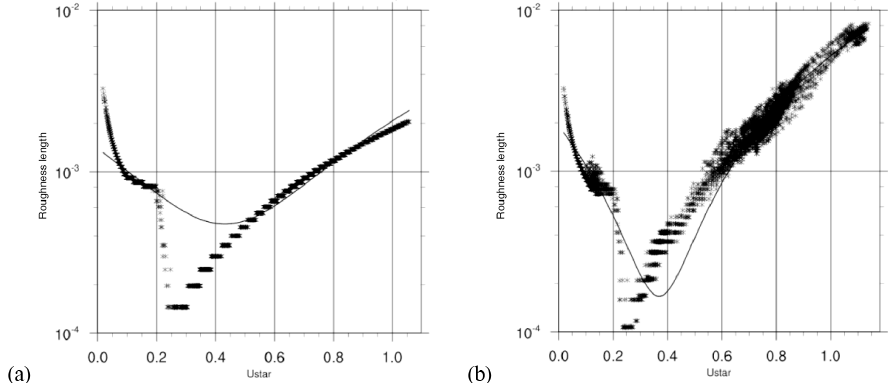
Figure 15. Roughness length (m) dependence to the friction velocity (ms − 1 ) for (a) the CTRL and (b) WEW experiments. The diagrams consist of selected sea points with severe winds during the period 4–11 January 2012. The solid lines stand for the polynomial curve fitting to the